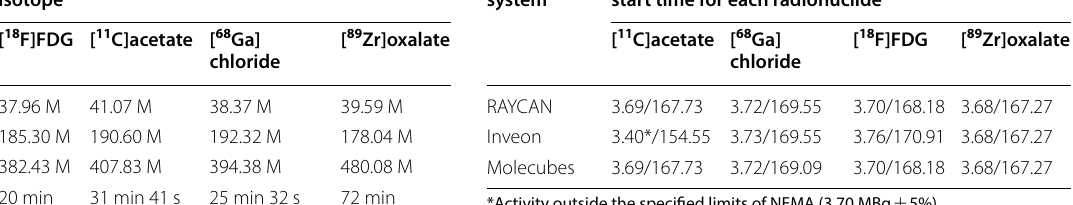
Table 3 Number of events recorded on each PET/ CT system and the final acquisition times used in the evaluation of different nuclei PET/CT system